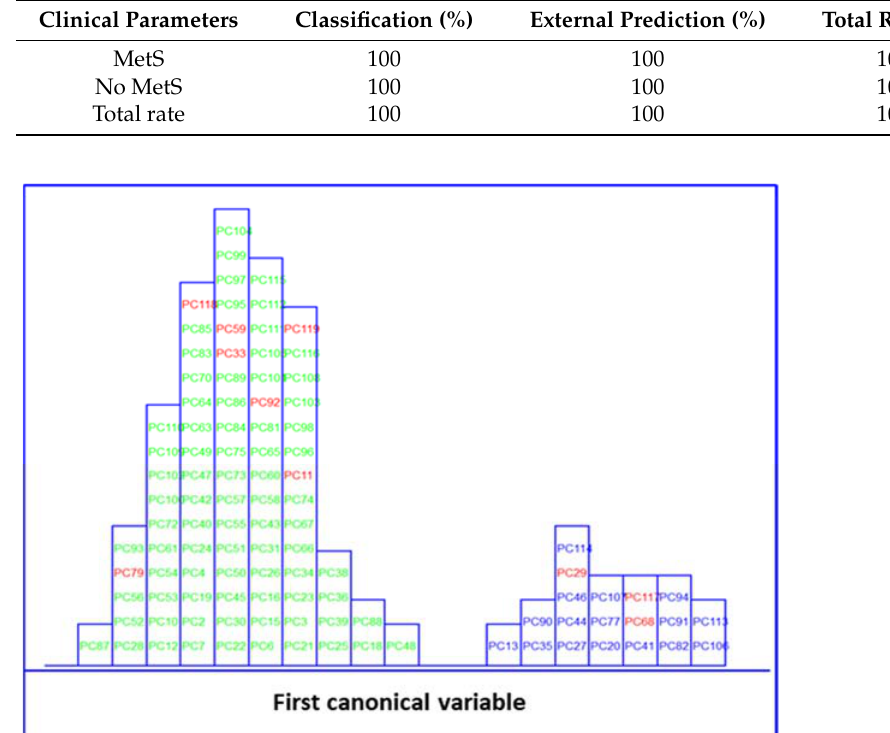
Figure 4. Histogram of the first canonical variable for the discrimination of MetS (  ) and no MetS (  ) patients within included (  ) test set, after performing LDA in the stratification approach based on clinical parameters ( y ‐ axis indicates the maximum discrimination power between categories).